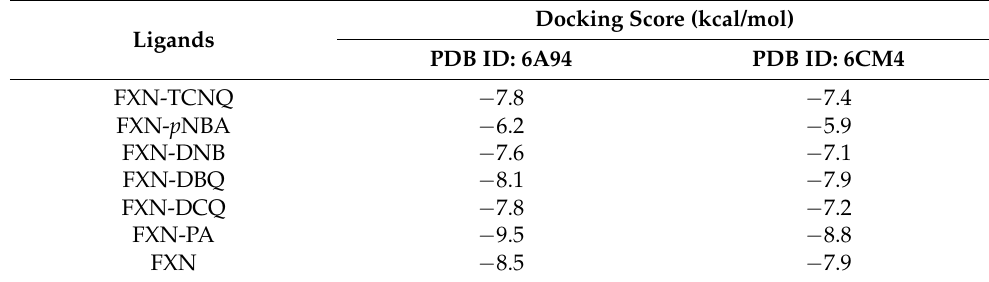
Table 1. Docking score of all [(FXN)( π -acceptor)] complexes and FXN drug alone into two protein